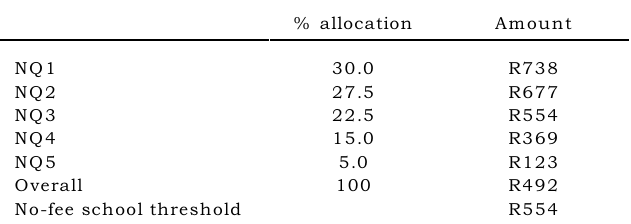
Table 1 National table of targets for school allocation for